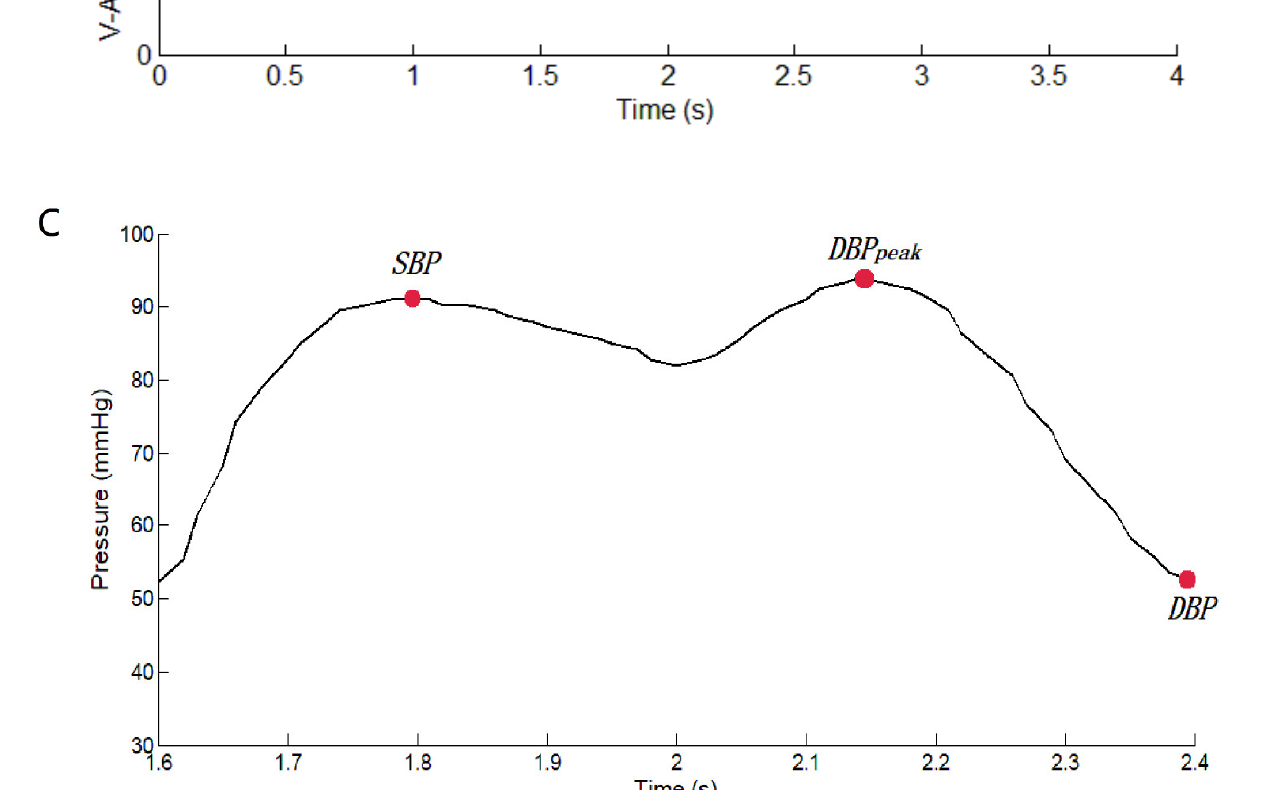
Figure 2. The flow velocity of the aortic valve and the flow of V-A ECMO. ( A ): the flow velocity of the aortic valve from the echocardiographs. CO is calculated by the formula CO = * * where V is the flow velocity of the aortic valve. A av is the area of the aortic valve (715.44 mm 2 ), and HR is the heart rate (75 bpm). ( B ): the flow of V-A ECMO, which is setting value. ( C ) The curve of arterial pressure with IABP support, which is marked with SBP, DBPpeak,